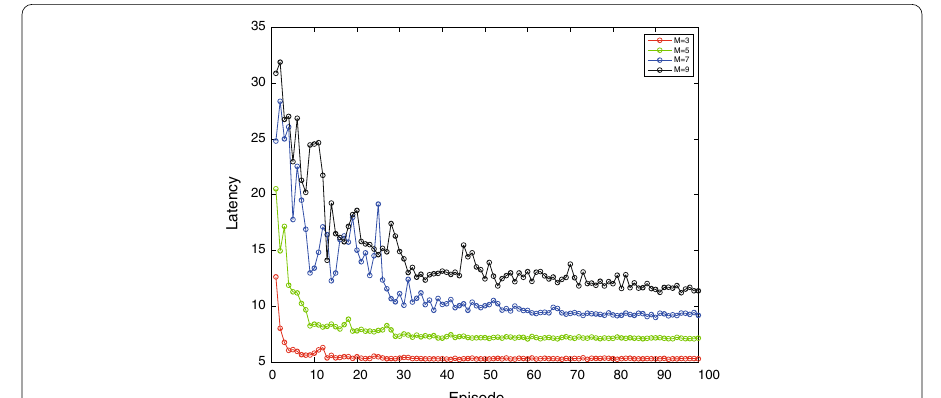
Fig. 4 Convergence of the proposed scheme with different number of users